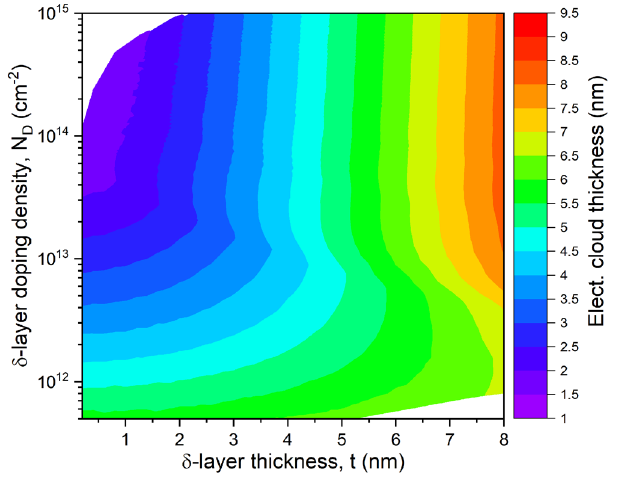
Fig. 4 Effective electron cloud thickness around the δ -layer plane. This result reveals that the dependence of the effective electron cloud on the δ - layer doping N D and thickness t is highly